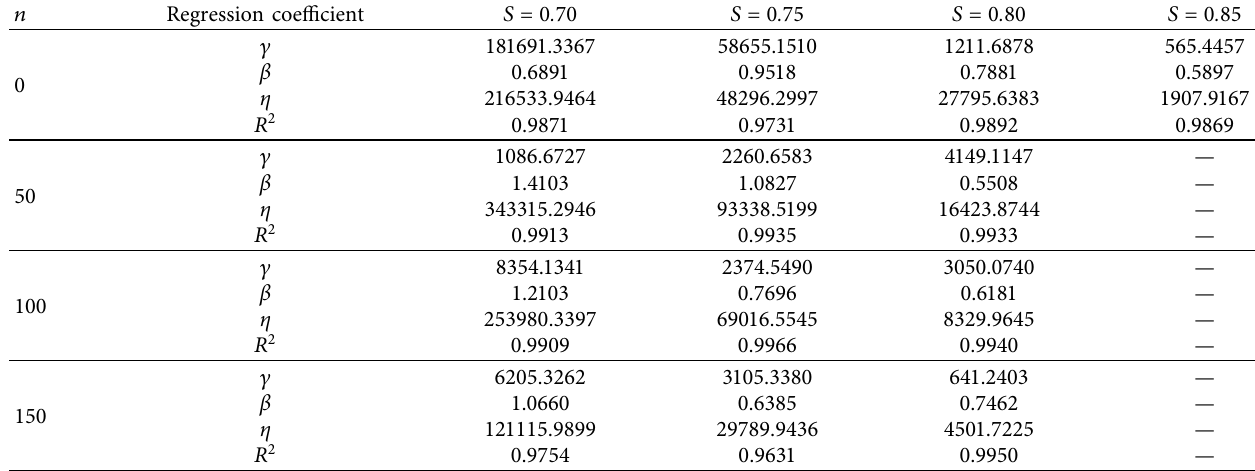
Table 9: Three-parameter Weibull distribution test analytic results.